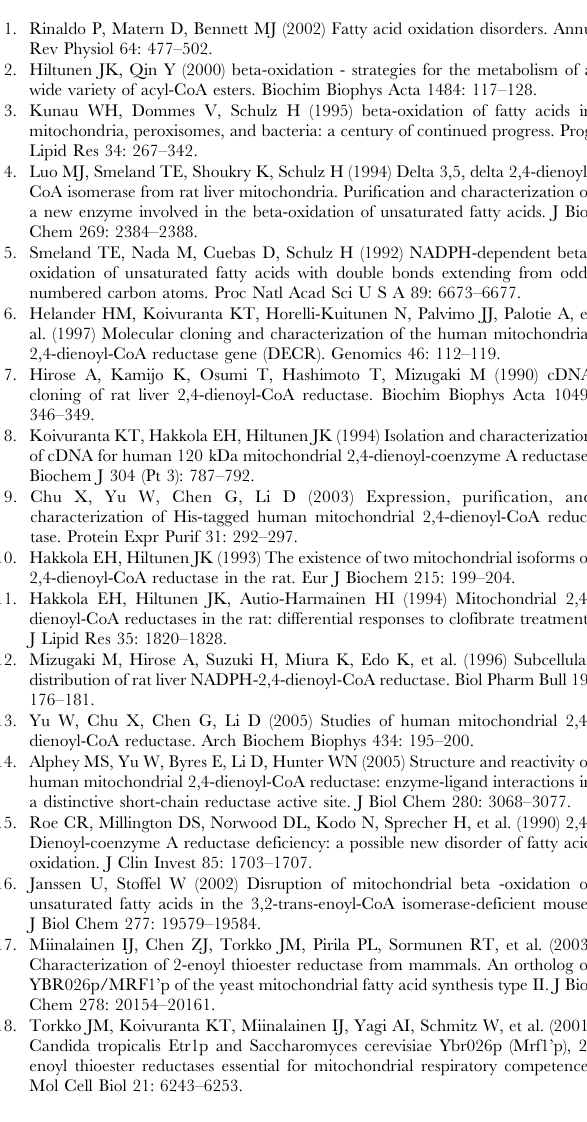
(fasted sample). Pooled samples were normalized to